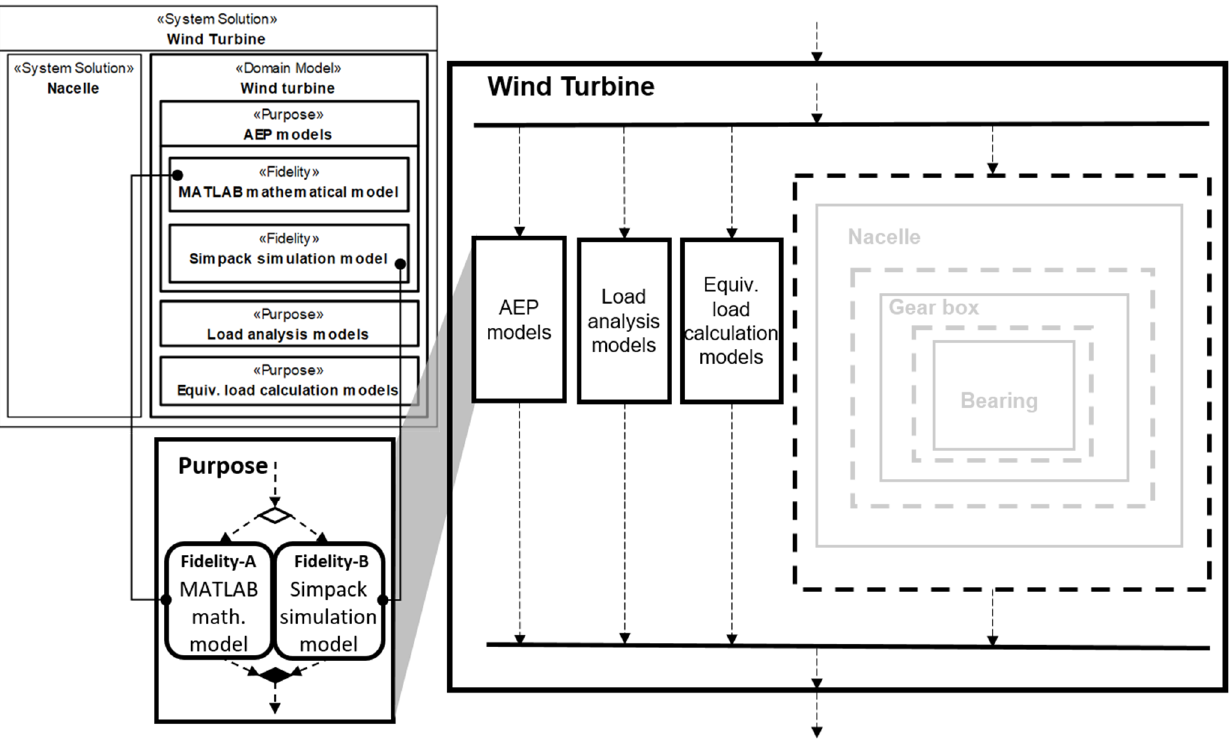
Figure 8. The nested framework of virtual testing workflows based on the model